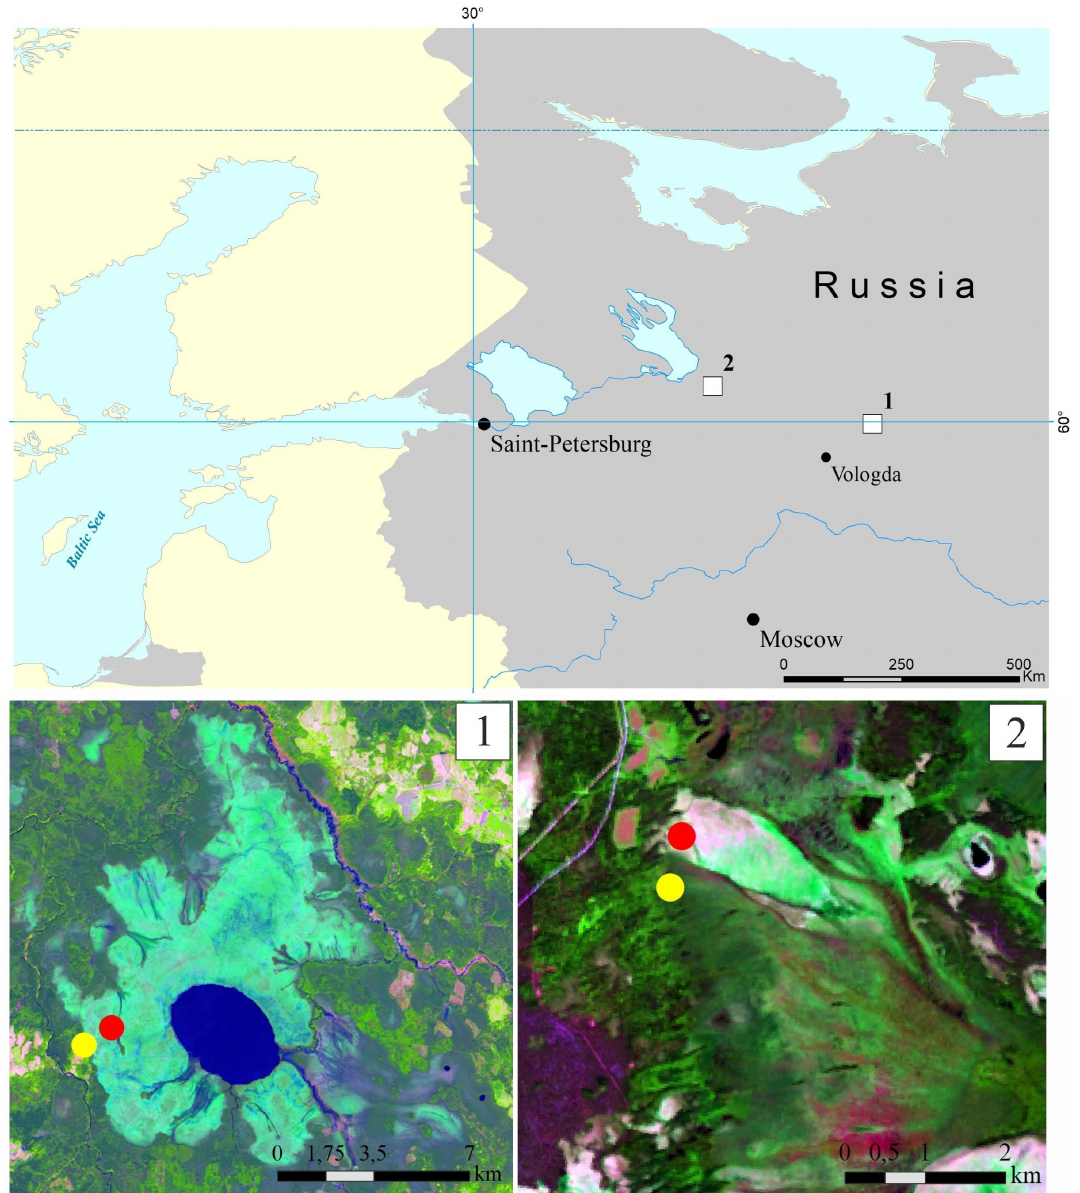
Figure 1. Location of the two study sites, the Shichengskoe ( 1 ) and Piyavochnoe ( 2 ) mires, on a map of European North Russia (upper panel). Sampling sites within the Shichengskoe ( 1 ) and Piyavochnoe ( 2 ) mires (bottom panel). Raised bogs and fens are indicated by red and yellow dots, respectively.